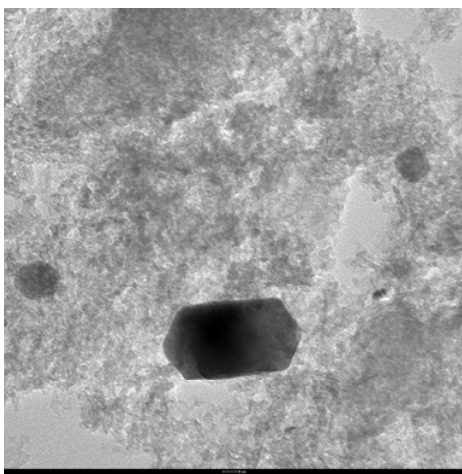
O -Fe O after Heck 2 3 2 3